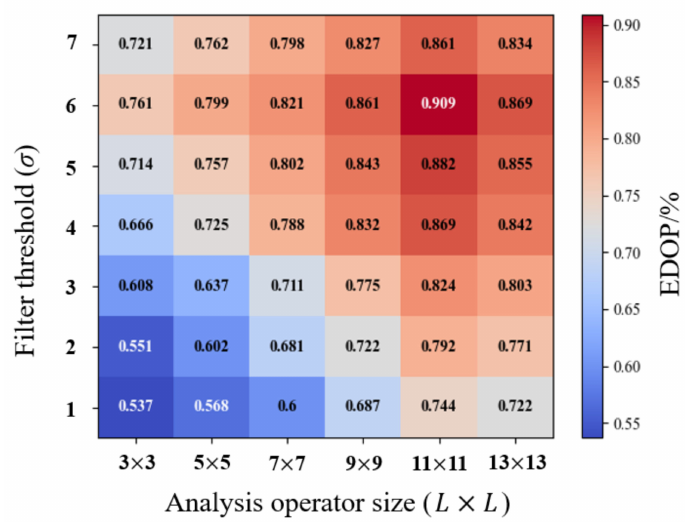
Figure 15. Two-factor heatmap of the effect of different values of L and σ on the extraction